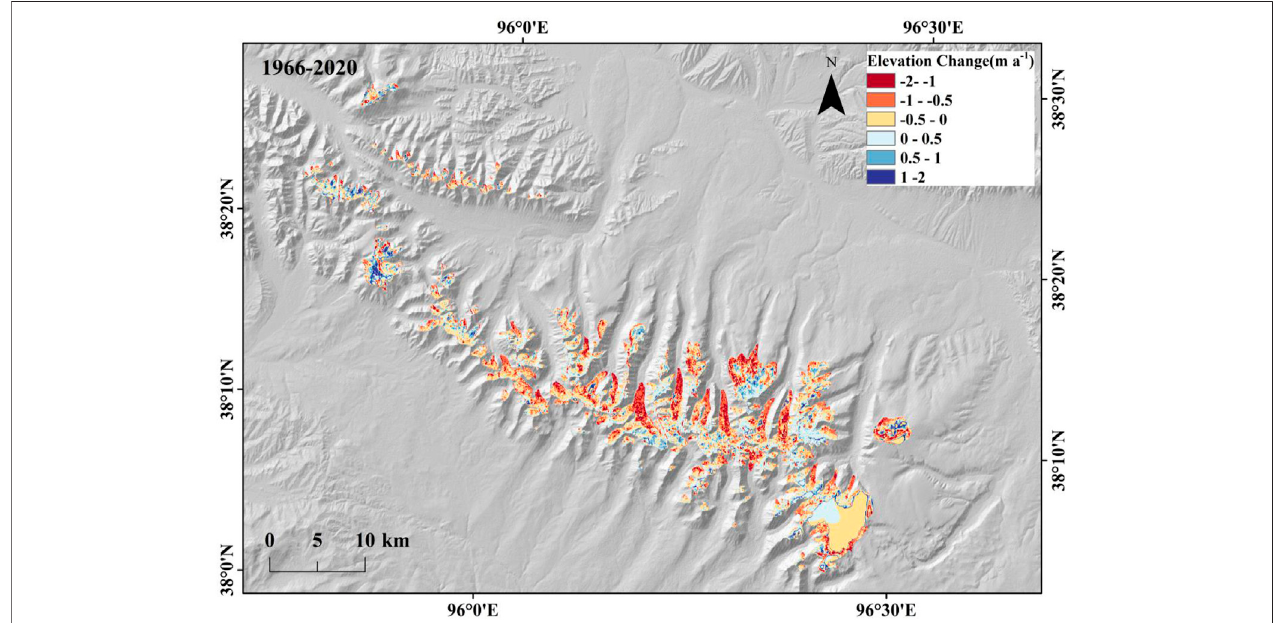
FIGURE 4 | Surface elevation changes of glaciers over the Turgen Daban Range from 1966 to 2020.